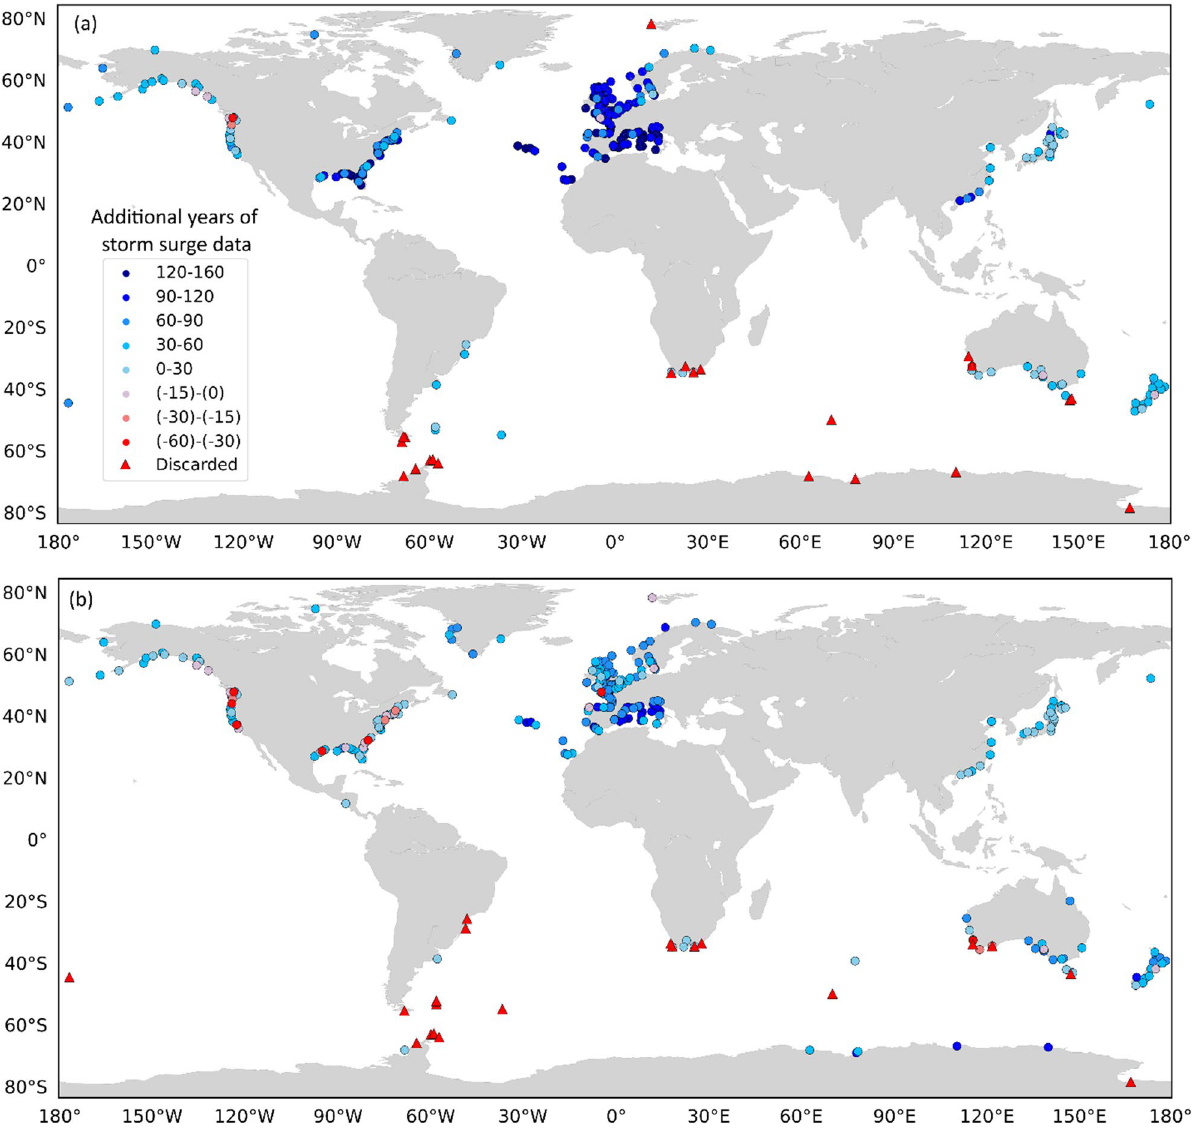
Figure 4. Additional years of reliable storm surge data after change point analysis obtained from G-20CR ( a ) and G-E20C ( b ) compared to the existing observed records. Negative numbers indicate that reliable surge reconstructions are shorter than observations. Red triangles represent tide gauges where surge reconstructions are rejected. Rossum, Guido van, et al., The Python Language Reference, Python Software Foundation; http:// docs. python. org/ py3k/ refer ence/ index.